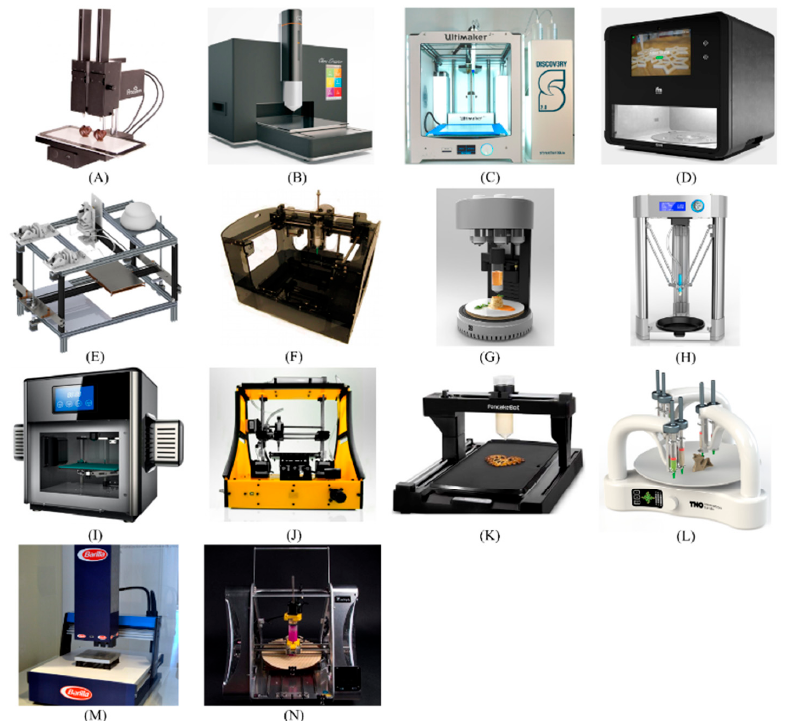
Figure 1. Various pictures of 3D food printing systems. ( A ) Procusini 3.0 Dual, ( B ) Choc Creator V2.0 Plus, ( C ) Discov3ry 2.0 paste extruder paired with the Ultimaker 2+, ( D ) Foodini, ( E ) F3D, ( F ) Fab@Home, ( G ) Sanna, ( H ) Model F5, ( I ) QiaoKe chocolate printer, ( J ) BeeHex printer, ( K ) PancakeBot 2.0, ( L ) The 3D everything concept printer, ( M ) Barilla 3D pasta printer, ( N ) Zmorph 2.0 VX